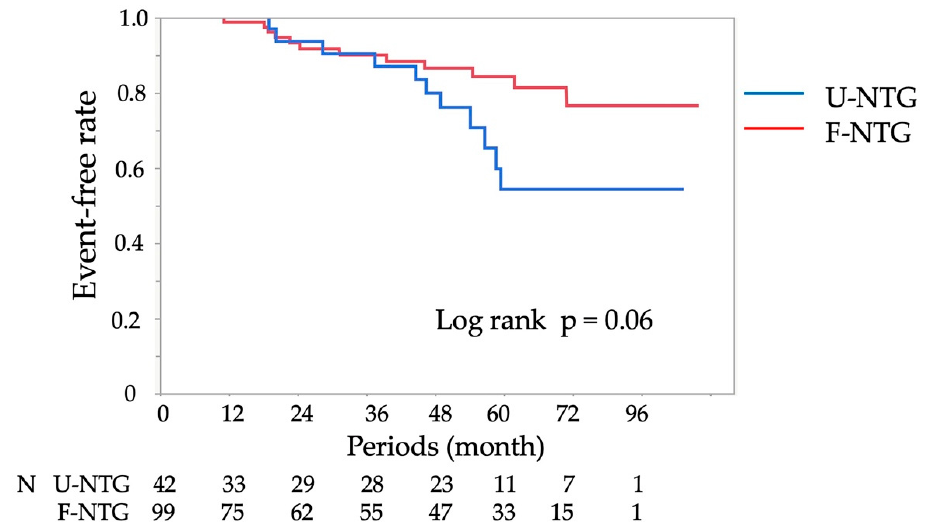
Figure 2. Kaplan–Meier curve for MACE-free survival during the follow-up period for the U-NTG Figure 2. Kaplan–Meier curve for MACE ‐ free survival during the follow ‐ up period for the U ‐ NTG and F-NTG groups. F-NTG, final use of nitroglycerin; MACE, major adverse cardiac event; NTG, and F ‐ NTG groups. F ‐ NTG, final use of nitroglycerin; MACE, major adverse cardiac event; NTG, nitroglycerin; U ‐ NTG, unavoidable use of nitroglycerin. nitroglycerin; U-NTG, unavoidable use of 3.4. A Second SPT in Another Coronary Artery after an Unavoidable Use of NTG In the U ‐ NTG groups, the median time from an unavoidable use of NTG to the next SPT in another coronary artery was 8 ± 5 min. Among the 42 patients in the U ‐ NTG group, 17 (40%) showed a positive SPT in another coronary artery (Re ‐ spasm [+] group), whereas 25 showed a negative SPT (ND) in another coronary artery (Re ‐ spasm [ − ] group), as shown in Figure 1 and Table 5. As a result, the frequency of MVS was 100% in the Re ‐ spasm (+) group. Conversely, the frequency of MVS was 40% in the Re ‐ spasm ( − ) group because this group included 10 patients who had already been diagnosed with MVS due to simultane ‐ ous coronary spasms in the LAD and LCX during the first SPT for LCA (Figure 3). In the Re ‐ spasm (+) group, the patients tended to be older included ( p = 0.05) and the frequency of current smokers was significantly lower ( p < 0.01). NID on brachial sonography was significantly lower in the Re ‐ spasm (+) group ( p = 0.03), whereas the baseline brachial di ‐ ameter and FMD were similar between the two groups. No differences were observed between the two groups in terms of which vessel was first provoked for SPT ( p = 0.21) or the time between NTG administration and the next SPT ( p = 0.33). The final dose of ACh did not differ between the two groups ( p = 0.17). Logistic regression analysis for the pres ‐ ence of Re ‐ spasm (+) using the current smoker status (odds ratio 2.7, p = 0.10) and NID (odds ratio 2.0, p = 0.16) could not show the significant factors responsible for the presence of Re ‐ spasm (+). Table 5. Results of a second SPT in another coronary artery. Re ‐ Spasm ( − )